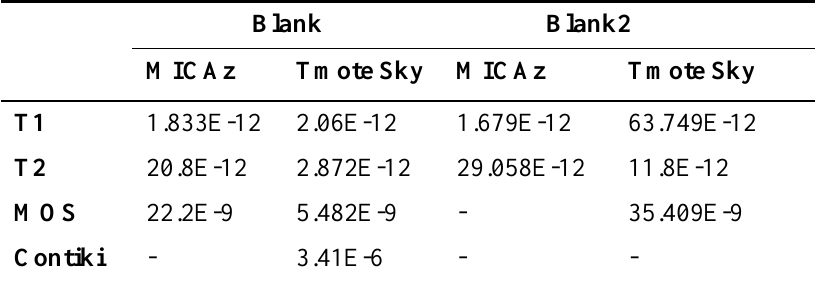
Table 4. Variance of the current samples taken.